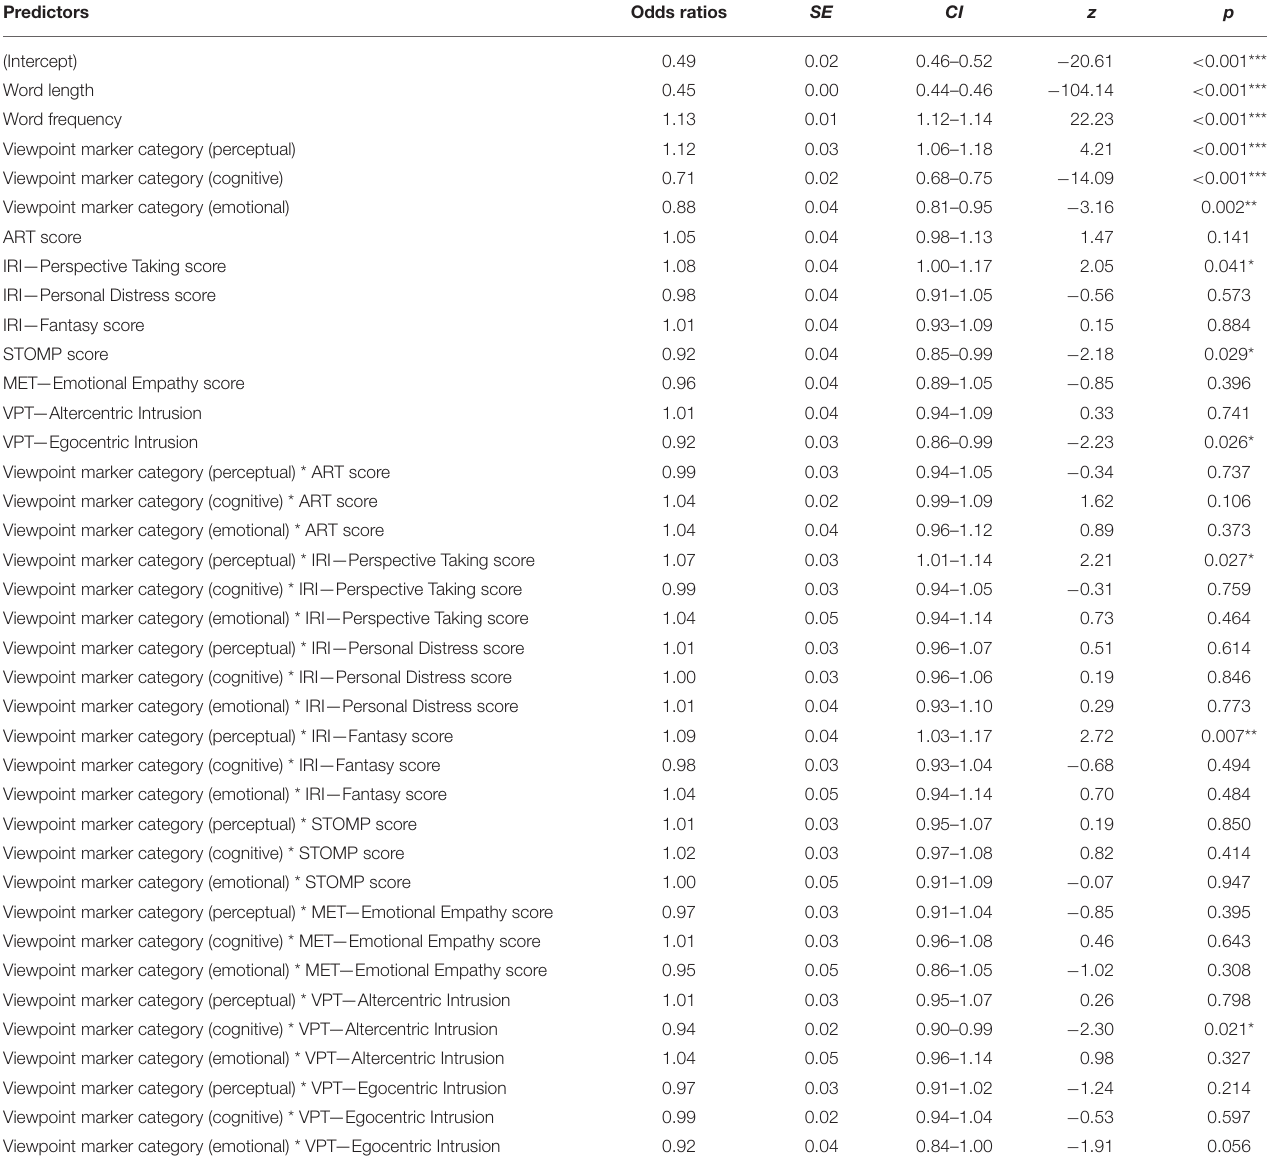
TABLE 4 | Estimates for the generalized linear mixed model predicting skip